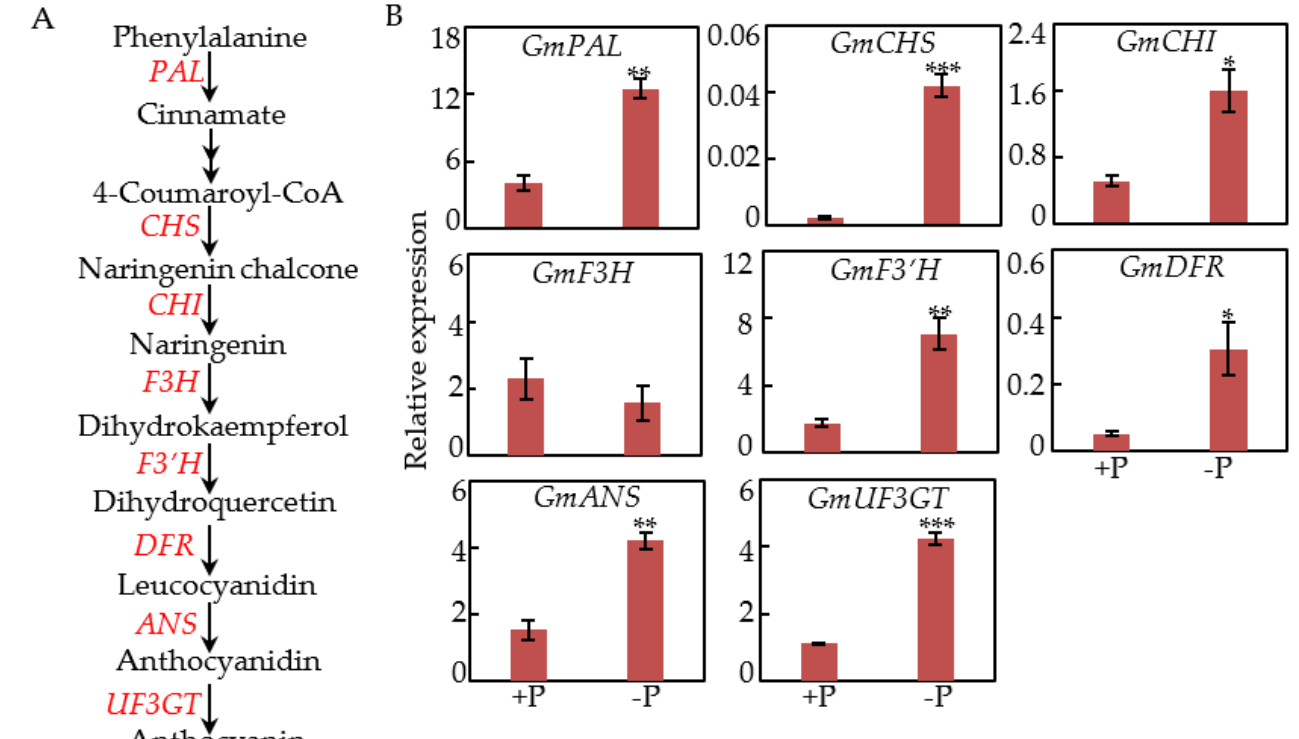
Figure 2. Transcripts of eight genes in anthocyanin biosynthetic pathway in soybean leaves at two P levels. ( A ) The genes in anthocyanin biosynthetic pathway. ( B ) Relative expression of genes in anthocyanin biosynthetic pathway under Pi-sufficient (+P) and Pi-deficient ( − P) conditions. Data are means of four independent replicates ± SE. Asterisks indicate significant difference between the two P levels in the Student’s t -test (* p < 0.05; ** p < 0.01; *** p < 0.001).